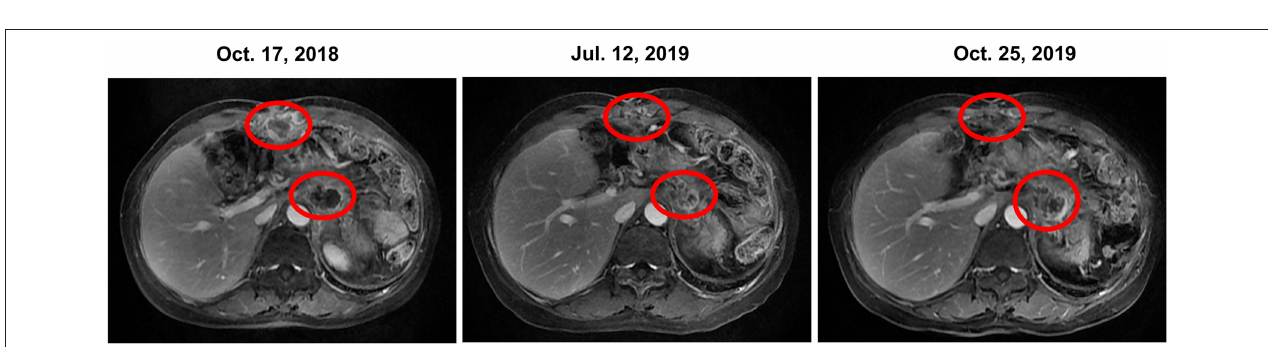
FIGURE 2 | Change in the tumor prior to, during and following olaparib therapy based on representative MRI. In October 2018, prior to olaparib therapy, MRI showed anterior abdominal wall mass and retroperitoneal mass. Continuous stable disease was observed for 12 months during olaparib (with or without irinotecan) therapy. However, the retroperitoneal mass enlarged in October 2019, meanwhile, the CA19-9 level increased dramatically. Thus, the patient was transferred to SOX chemotherapy. CA19-9, carbohydrate antigen 19-9; MRI, magnetic resonance images; SOX, S-1 plus oxaliplatin.